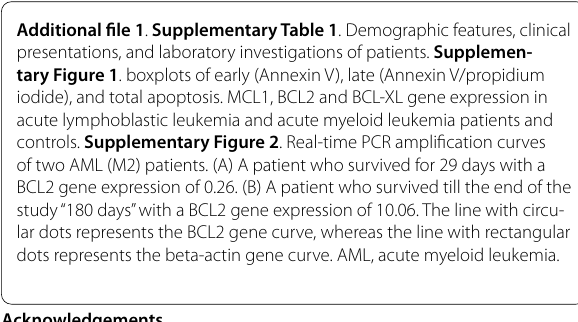
tary Figure 1 . boxplots of early (Annexin V), late (Annexin V/propidium iodide), and total apoptosis. MCL1, BCL2 and BCL‑XL gene expression in acute lymphoblastic leukemia and acute myeloid leukemia patients and controls. Supplementary Figure 2 . Real‑time PCR amplification